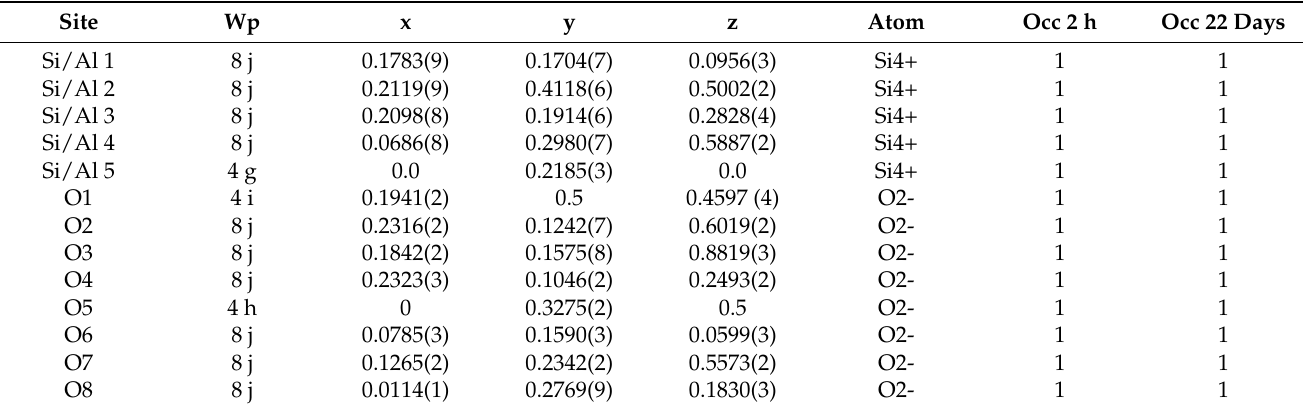
Figure 3. Difference plot of the powder XRD experimental and calculated pattern of Cd-clinoptilolite (90 °C, 22 days). Finishing the structural refinements of all Cd-exchanged clinoptilolite we obtain the values for the structural parameters. For the samples (90 ◦ C, 22 days) and (90 ◦ C, 2 h) these values are given in Table 4 and the interatomic distances are shown in Table 5. Table 4. Atomic coordinates, Wyckoff positions, and occupancy factors of samples Cd-clinoptilolite (90 ◦ C, 22 days) and Cd-clinoptilolite (90 ◦ C, 2